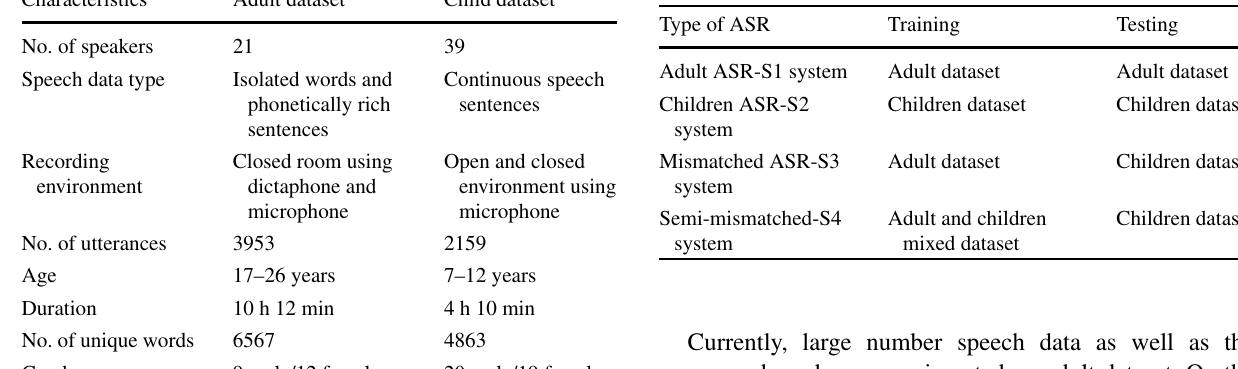
Table 2 Differentmatchedormismatchedsystememployedfortraining and